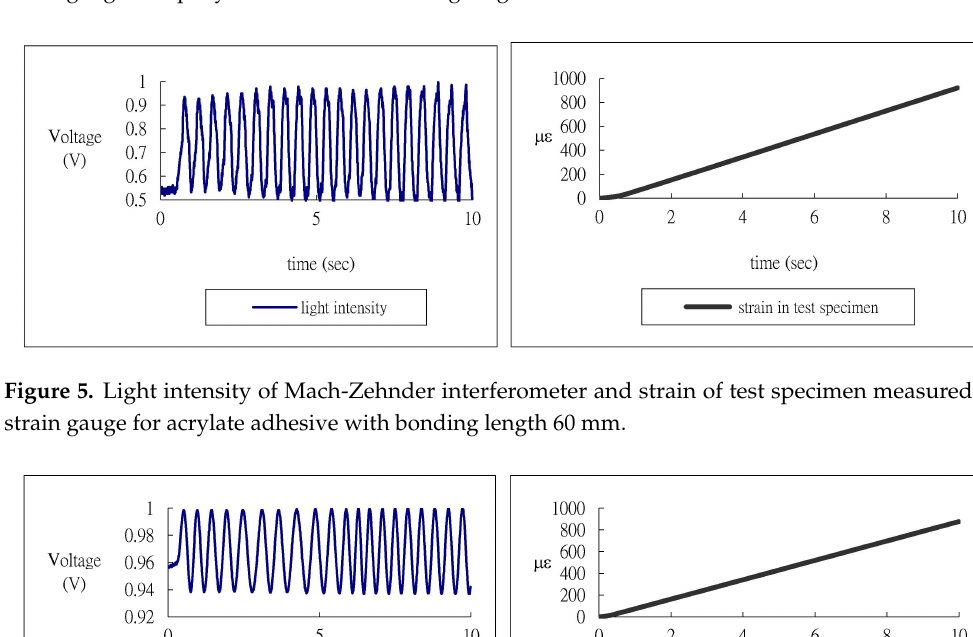
Figure 5. Light intensity of Mach-Zehnder interferometer and strain of test specimen measured by strain gauge for acrylate adhesive with bonding length 60 mm. Figure 6. Light intensity of Mach-Zehnder interferometer and strain of test specimen measured by strain gauge for M-coat adhesive with bonding length 60